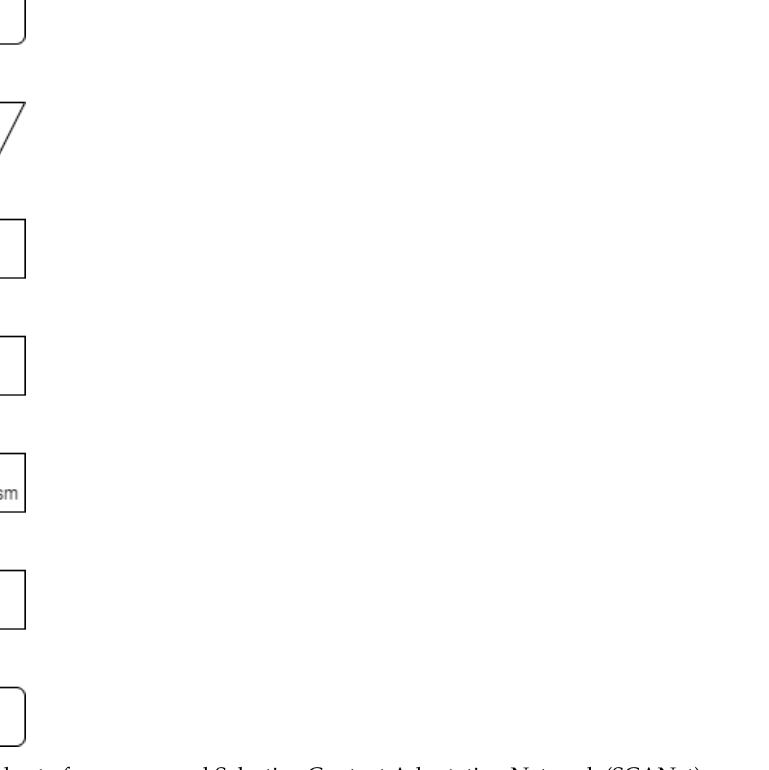
Figure 1. Flowchart of our proposed Selective Context Adaptation Network (SCANet).